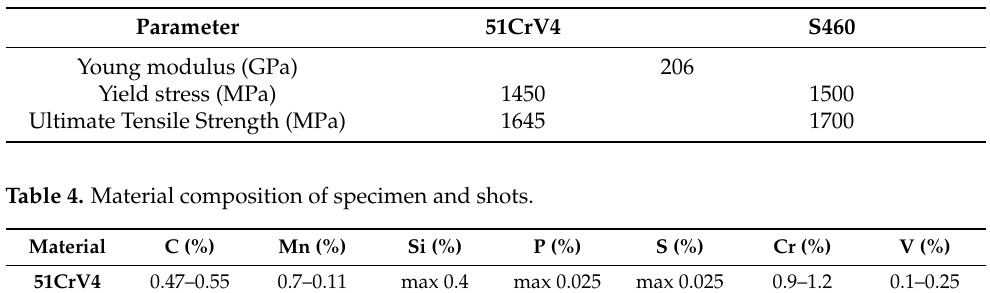
Table 3. Key material data for both specimen and shots.